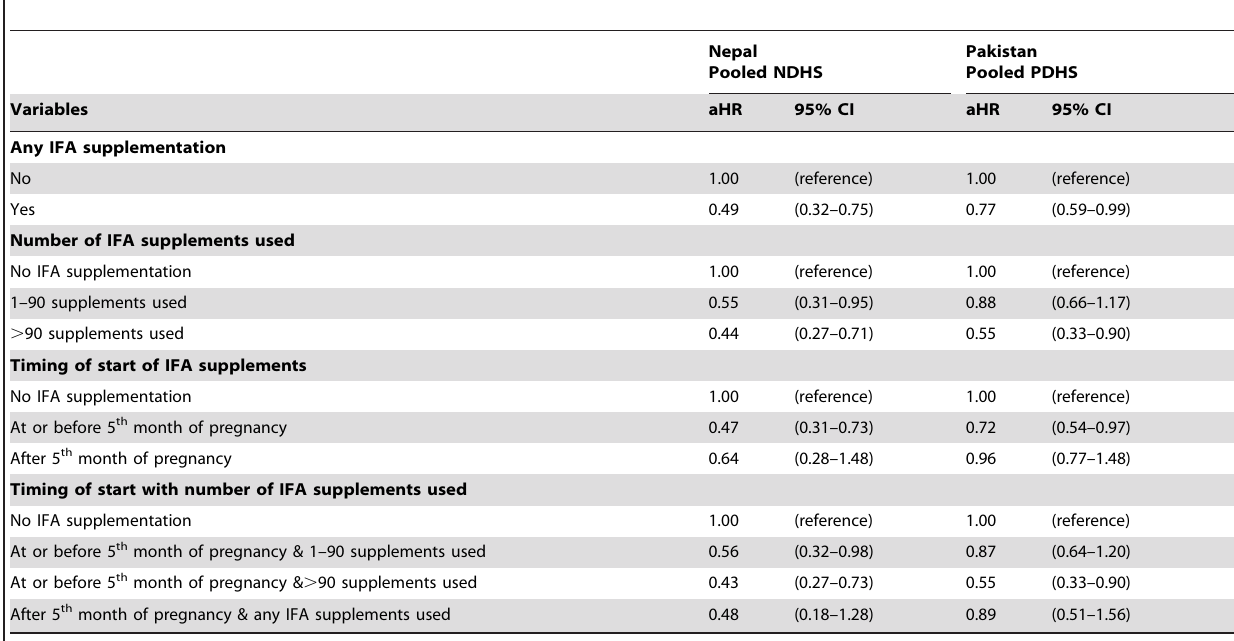
Table 4. Effect of any iron-folic acid (IFA) supplements, number of supplements used, timing of start of supplements and timing of start with number of supplements used on early neonatal mortality determined by multivariate analysis in Nepal and Pakistan.